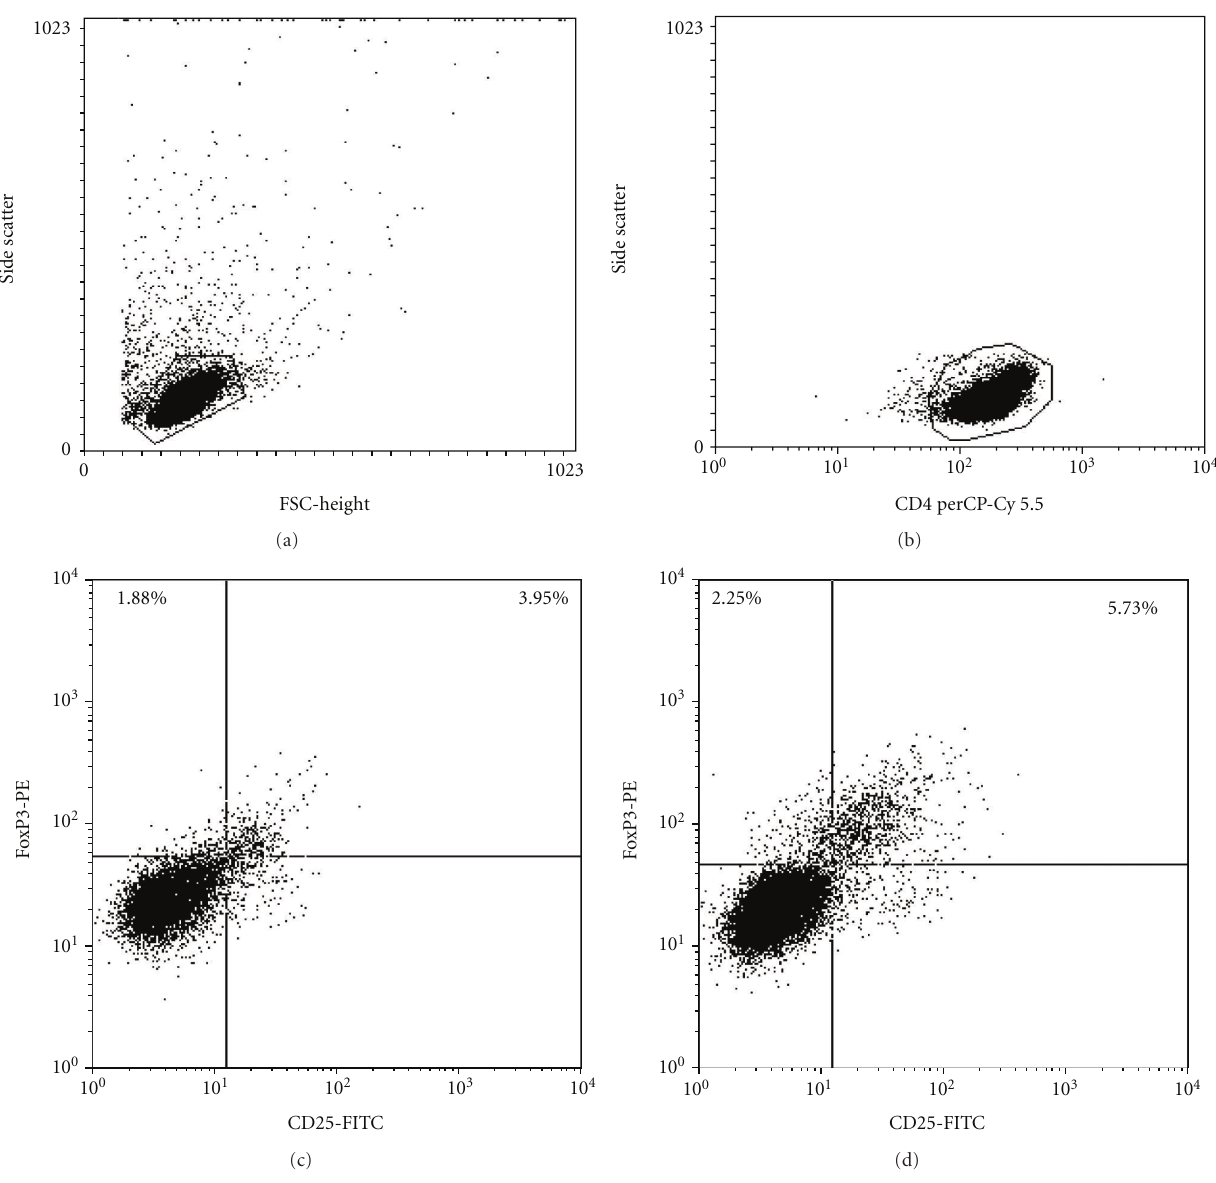
Figure 1: A representative dot plot showing the expression of CD25 and FoxP3 markers by T helpers. Panels (a) and (b) show the homogeneity of the purified CD4+ population; (c) shows the percentage of FoxP3+ cells in control culture; (d) shows an increase of the percentage of cells expressing FoxP3 after being cultured in AT-MSCs conditioned